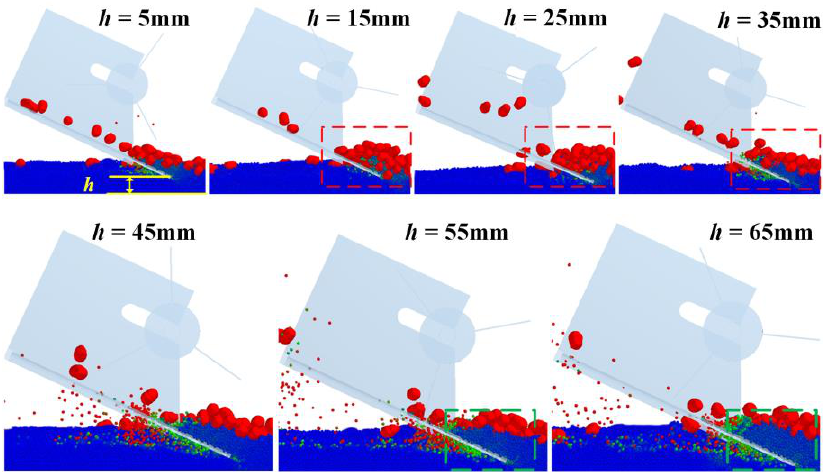
Figure 14. Simulation effect under different DCS.